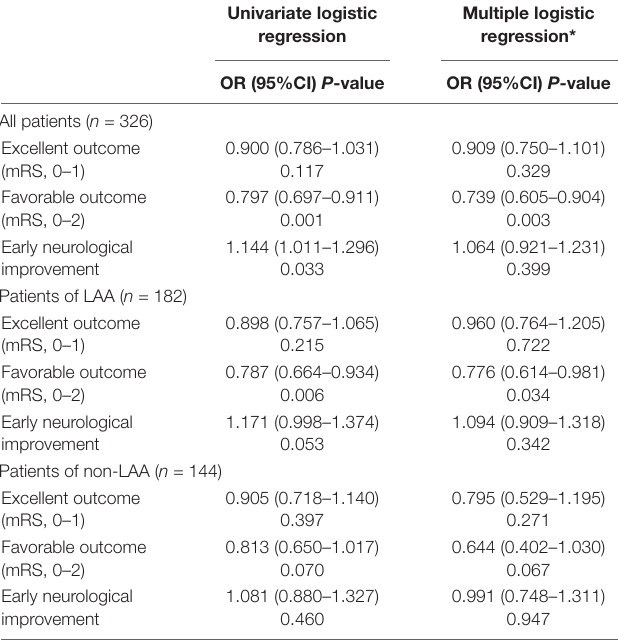
TABLE 3 | Association between HbA1c levels (as a continuous variable) and functional outcomes in subgroups. Univariate logistic Multiple logistic regression regression* OR (95%CI) P -value OR (95%CI) P